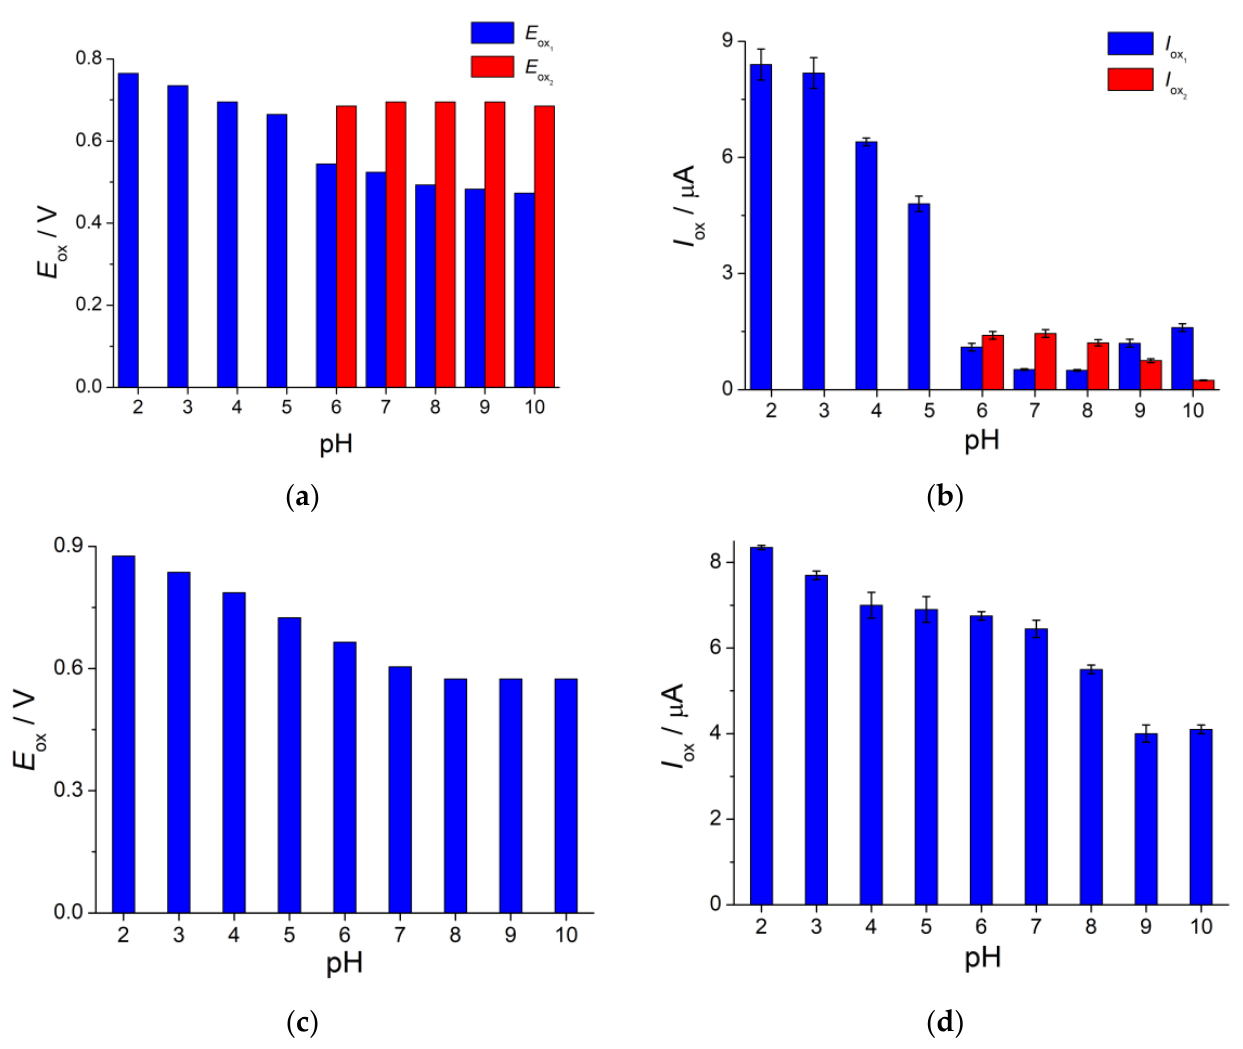
Figure 7. Voltammetric characteristics of 100 µM aromatic aldehydes at the poly( p -ABA)-modified electrode depending on the Britton–Robinson buffer pH: ( a ) Oxidation potentials of syringaldehyde; ( b ) Oxidation currents of syringaldehyde; ( c ) Oxidation potentials of vanillin; ( d ) Oxidation currents of vanillin.